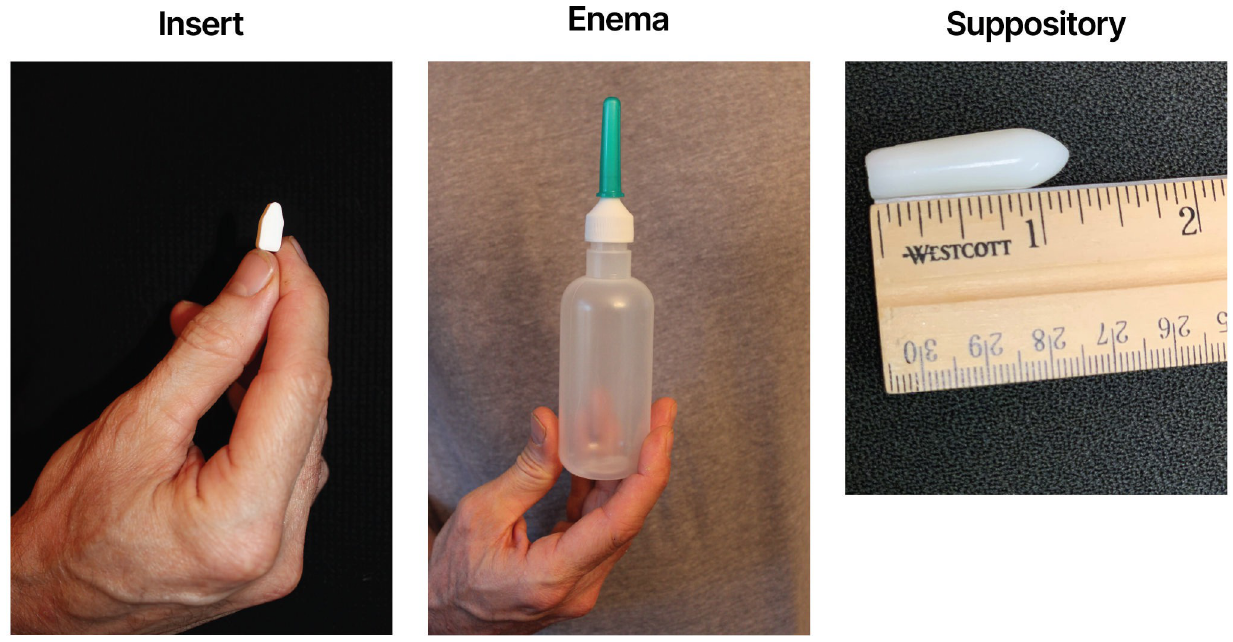
Fig 2. MTN-035 placebo study